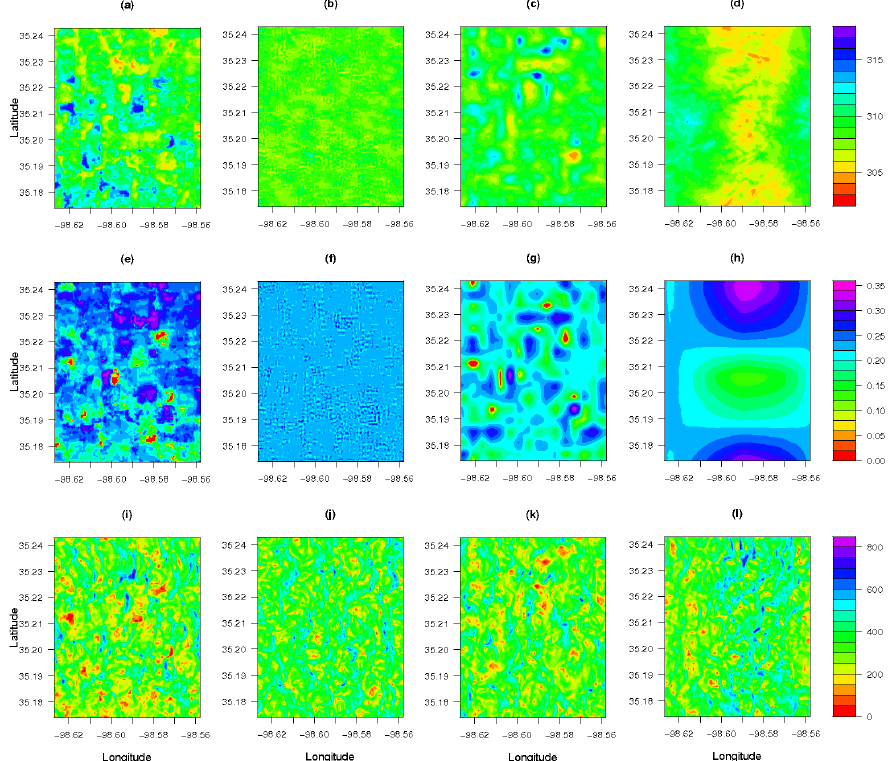
Fig. 3. (a–d) Surface temperatures [K] at 8h of simulation time under (a) using LandSAT ETM imagery (b) surface conditions band pass filtered to a length scale of 200m, (c) band pass filtered to 1600m and (d) band pass filtered to 12800m. (e–h) The same for soil moisture [kg kg − 1 ] and (i–l) . The same for surface latent heat flux [Wm − 2 ].